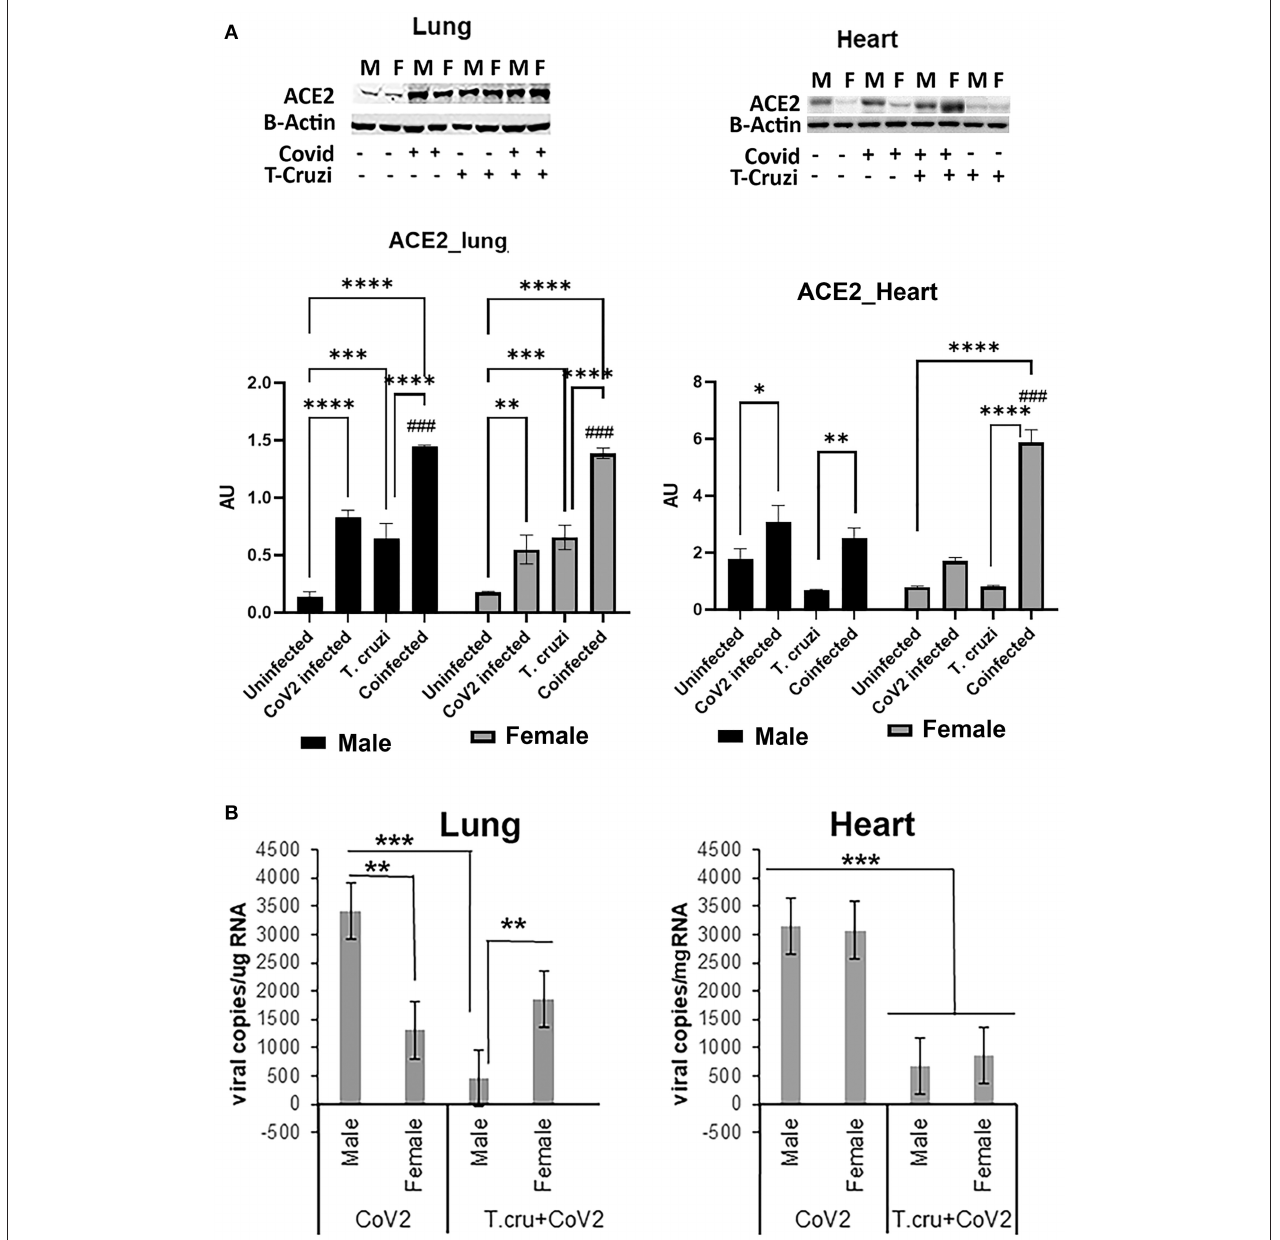
FIGURE 2 | Changes in ACE2 levels and viral load in the lungs and hearts of CoV2 infected, T. cruzi infected, and coinfected hACE2 mice. (A) Immunoblot analysis (upper panel) of ACE2 in the lungs (left) and hearts (right). GDI was used as loading control. Fold changes in the protein levels of ACE2 were normalized to GDI expression and are shown as a bar graph (A dot plot displaying individual data point is shown in Supplementary Figure 4 ). The error bars represent standard error of the mean. * p < 0.05, ** p < 0.01, *** p < 0.001 and **** p < 0.0001 compared to uninfected sex matched mice ( n = 4/sex/group) ( ### p < 0.001 for